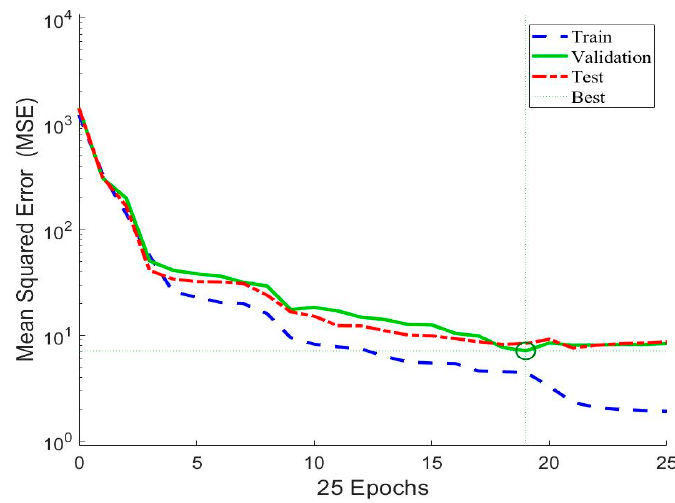
Figure 8. MLP model’s training performance status.